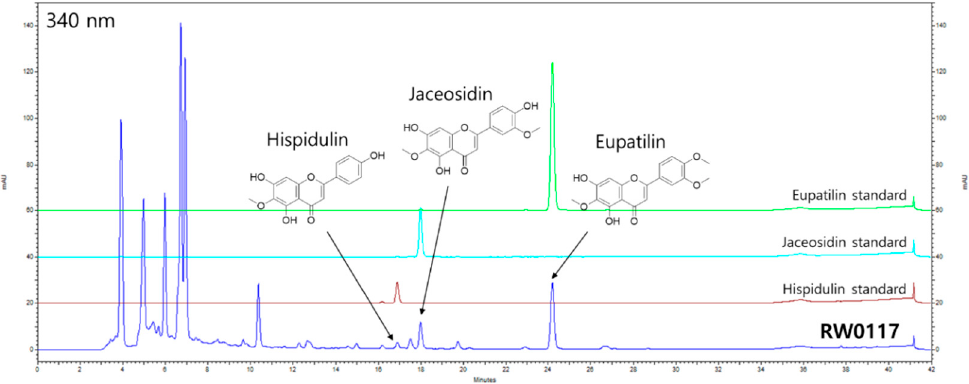
Figure 1. HPLC profiles of RW0117. The peak of eupatilin, jaceosidin, hispidulin at 340 nm in RW0117 were compared with those of their respective standard compounds.